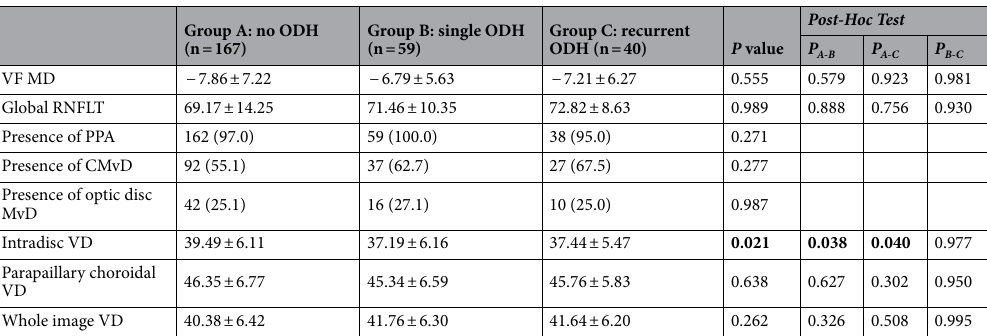
Table 2. Comparison of optical coherence tomography (OCT), visual field (VF), swept-source OCT angiography (SS-OCTA) parameters among POAG eyes with or without optic disc hemorrhage (ODH) at the time of SS-OCTA imaging. VF visual field, MD mean deviation, RNFLT retinal nerve fiber layer thickness, PPA parapapillary atrophy, CMvD choroidal microvascular dropout, MvD microvascular dropout, VD vessel density. Comparison was performed using one-way analysis of variance with post-hoc tests (Tukey or *Dunnett T3). Statistically significant values are in bold.